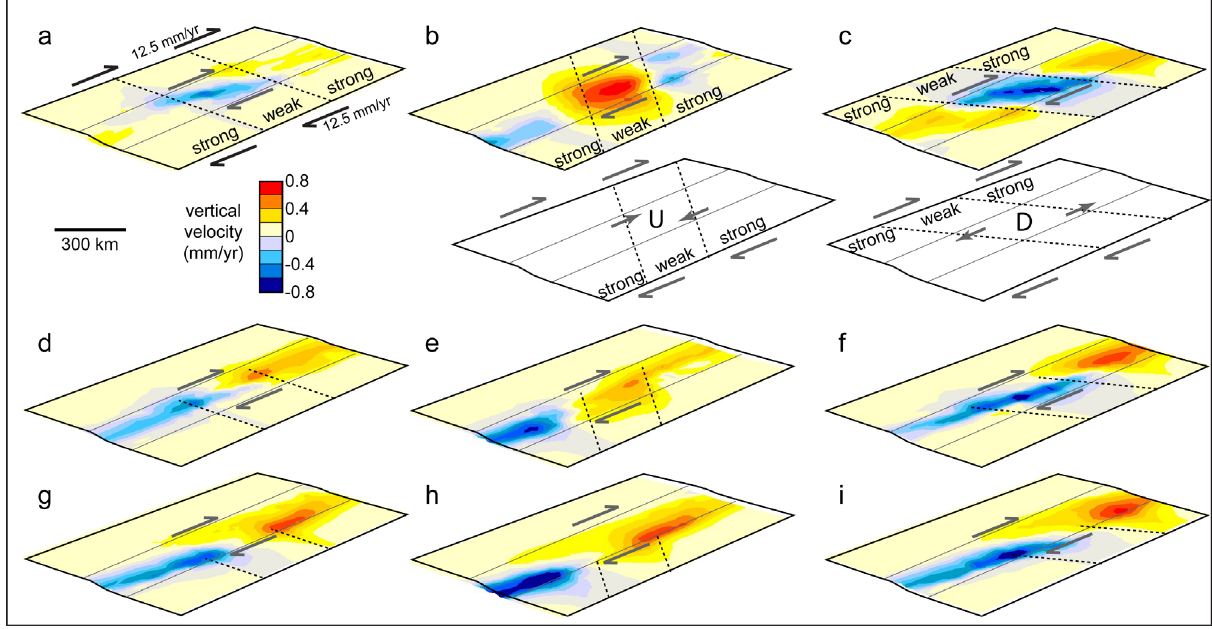
Figure 6. Maps of vertical velocities at the surface of the models with a 200 km wide deforming zone; ( a ) Weak zone extends across the whole model orthogonal to the boundary resulting in subsidence in the centre of the model; ( b ) Weak zone extends across the whole model at 45° to the boundary resulting in uplift in the centre of the model and subsidence to the north and south. Sketch below shows relative motion leading to uplift; ( c ) Weak zone extends across the whole model at 135° to the boundary resulting in subsidence in the centre of the mode and uplift to the north and south. Sketch below shows relative motion leading to subsidence; ( d ) Weak zone extends across half of model orthogonal to boundary with subsidence in south and uplift to the north; ( e ) Weak zone extends across half the model at an angle of 45° with subsidence south of the weak zone and uplift above and to the north of the weak zone; ( f ) Weak zone extends across half of the model at an angle of 135° with subsidence above and to the south of the weak zone and uplift restricted to north of the weak region; ( g – i ) Similar to ( d – f ) but weak zone extends only to the end of the deformation